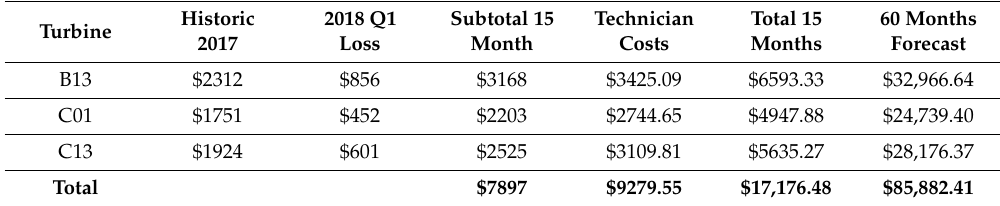
Table 7. Costs summary and 5-year forecast for the selected wind